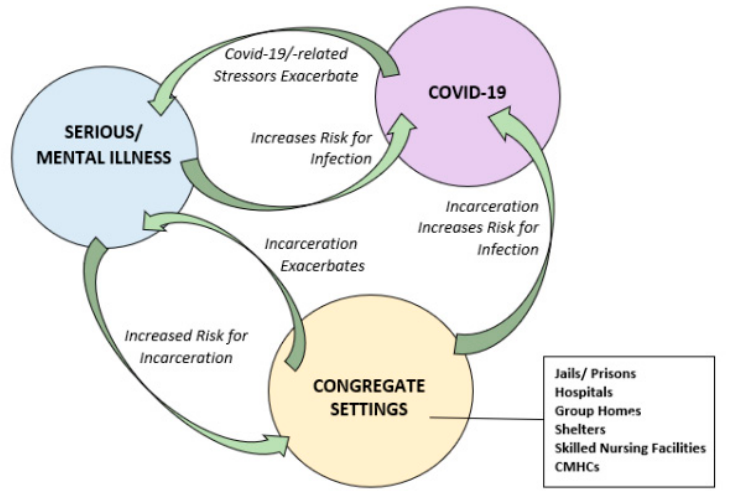
Figure 3. Risk relationships from a community mental health perspective in Intersection #1: COVID-19 and mental illness.